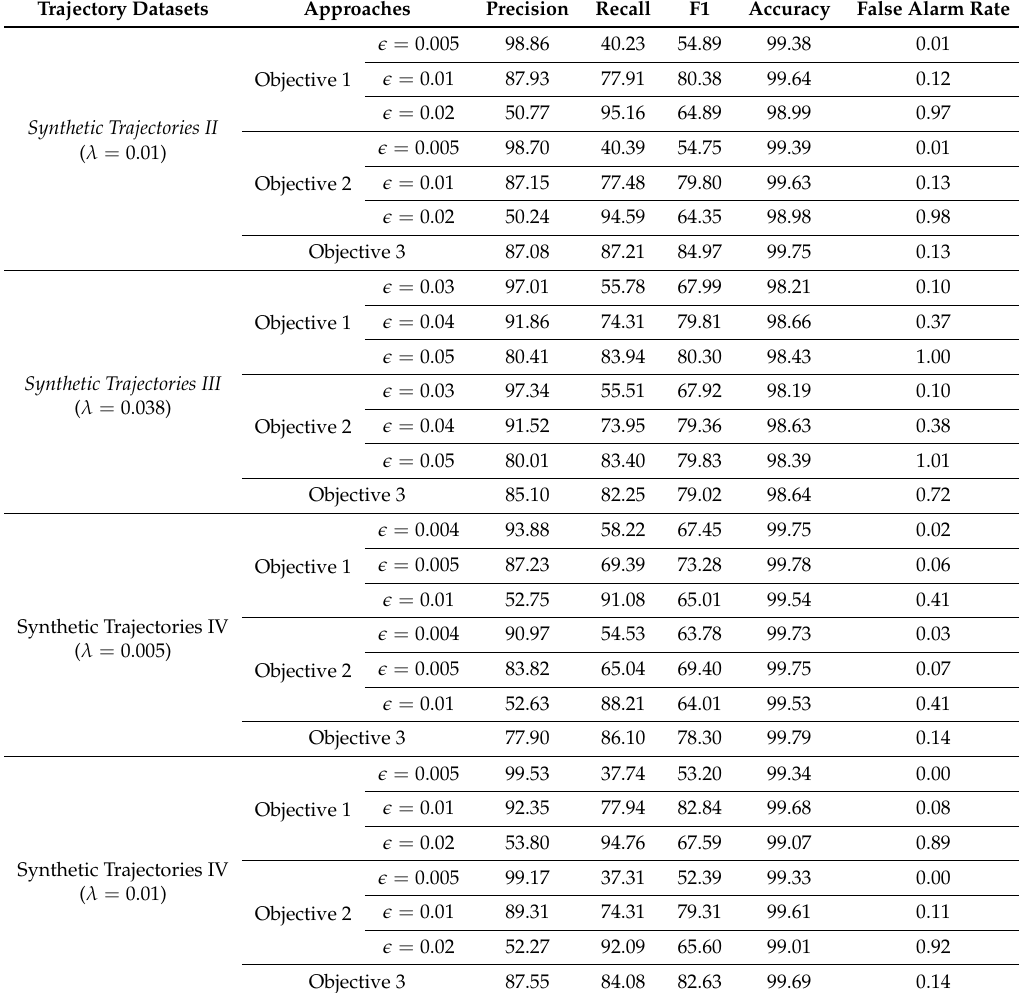
Table 5. Five Performance Measures (%) of Proposed Improvement Strategies on Different Trajectory Datasets. Trajectory Datasets Approaches Precision